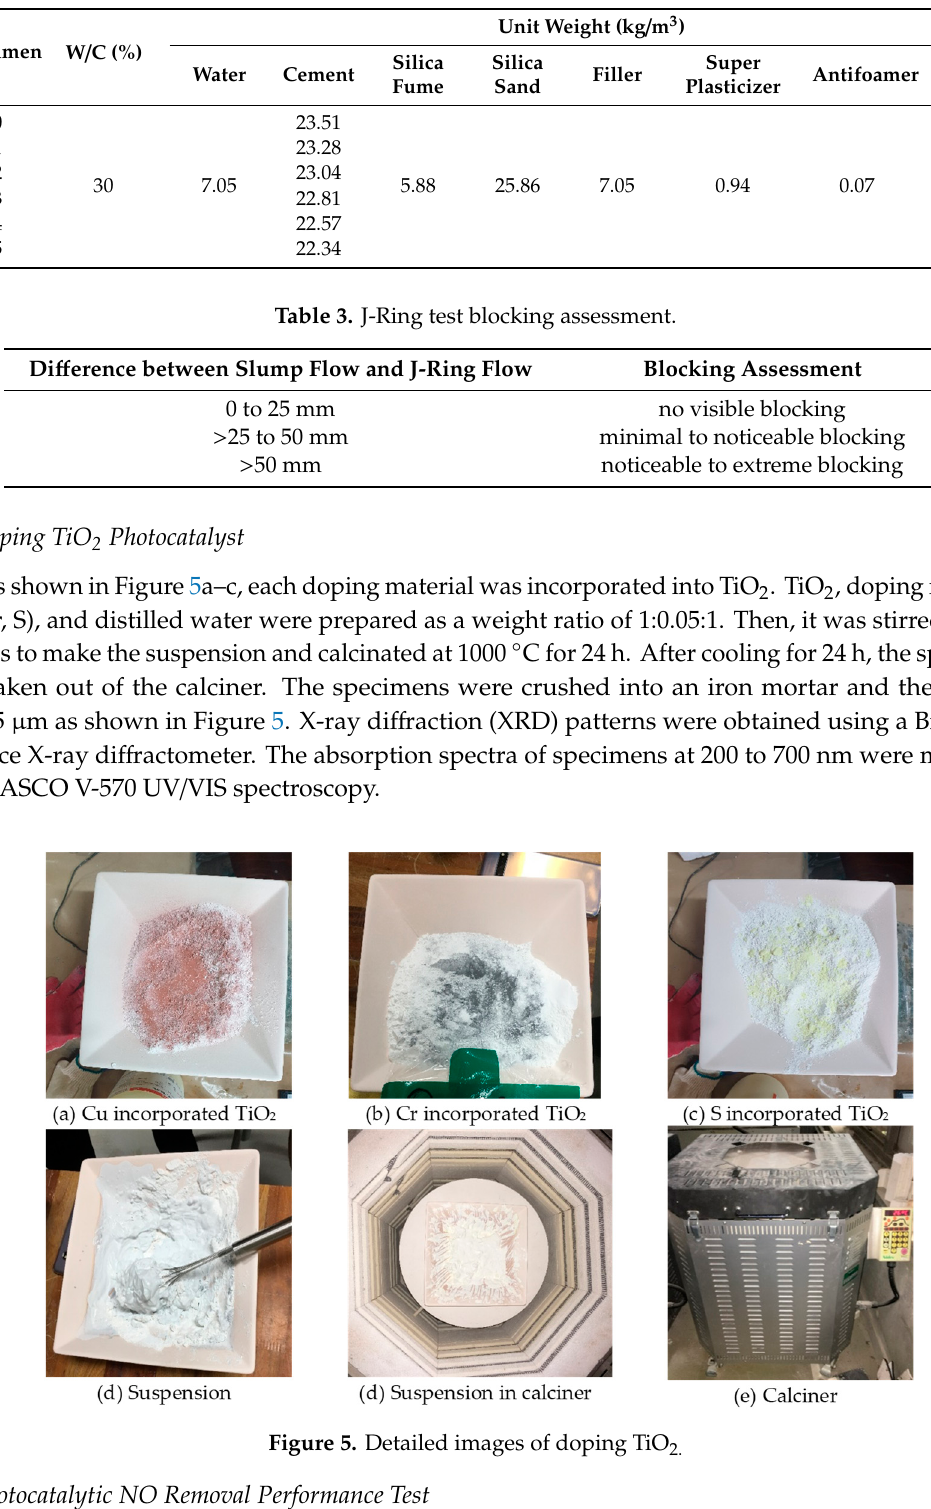
Table 2. Mix design of TiO 2 -incorporated UHPC (Ultra high performance concrete).